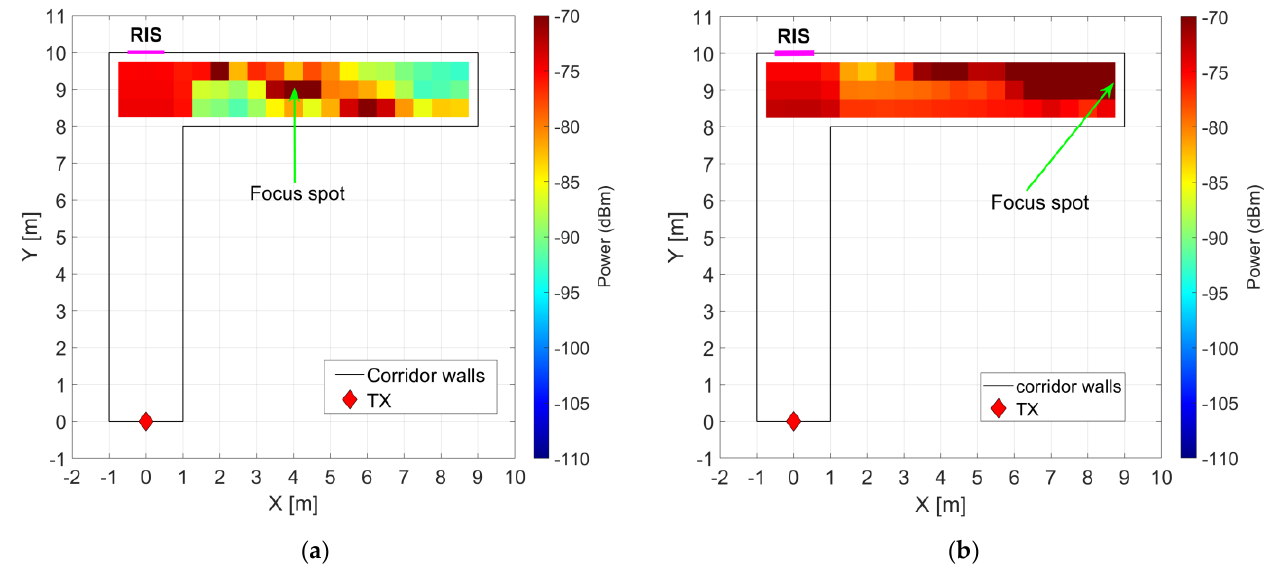
Figure 7. Coverage map in the L − shaped corridor, using an RIS configured as a focusing lens pointed toward the center ( a ) and the end ( b ) of the side corridor.